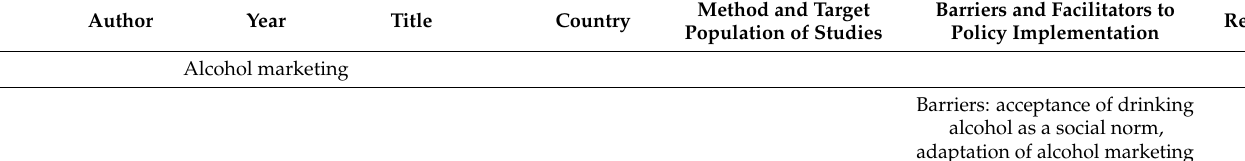
Table 1. Barriers and facilitators to policy implementation among the four policies.